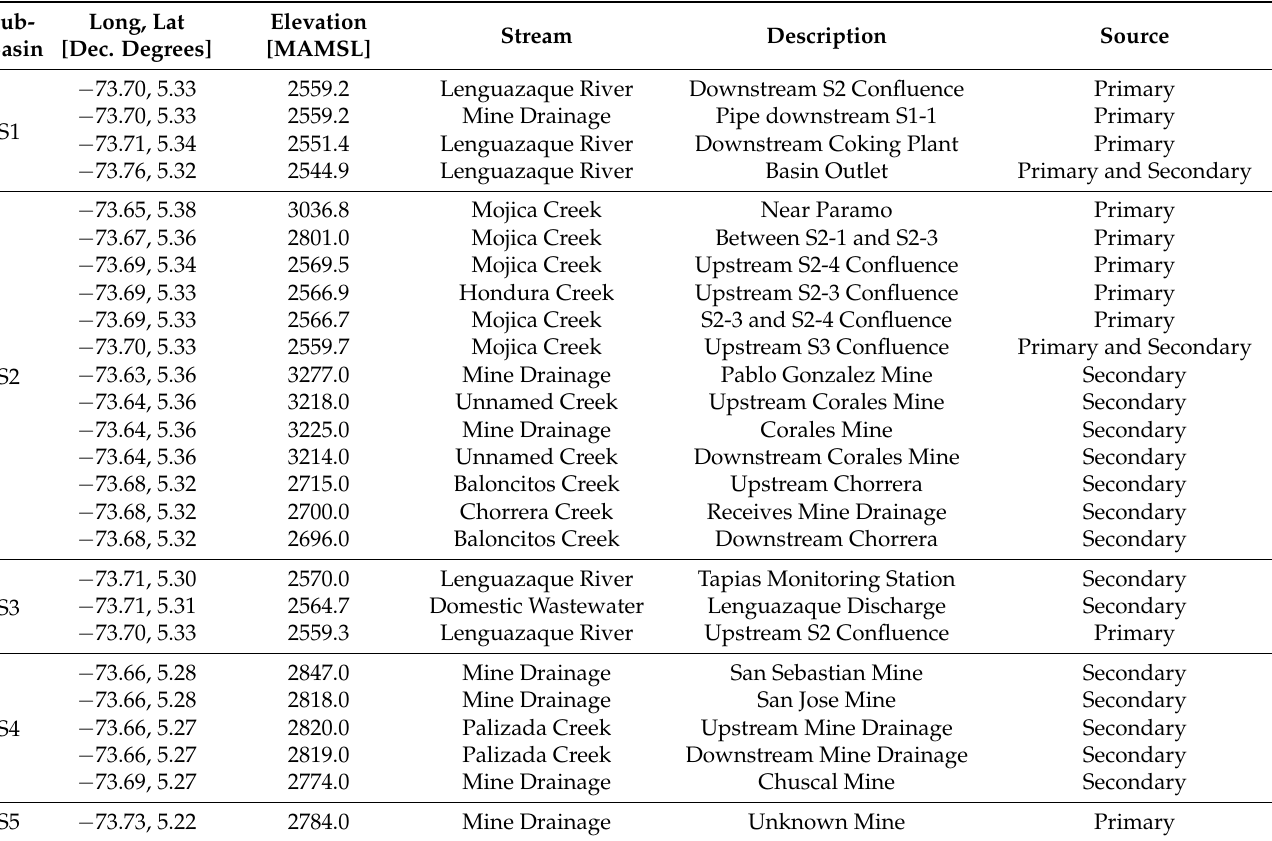
Table A1. Description of monitoring